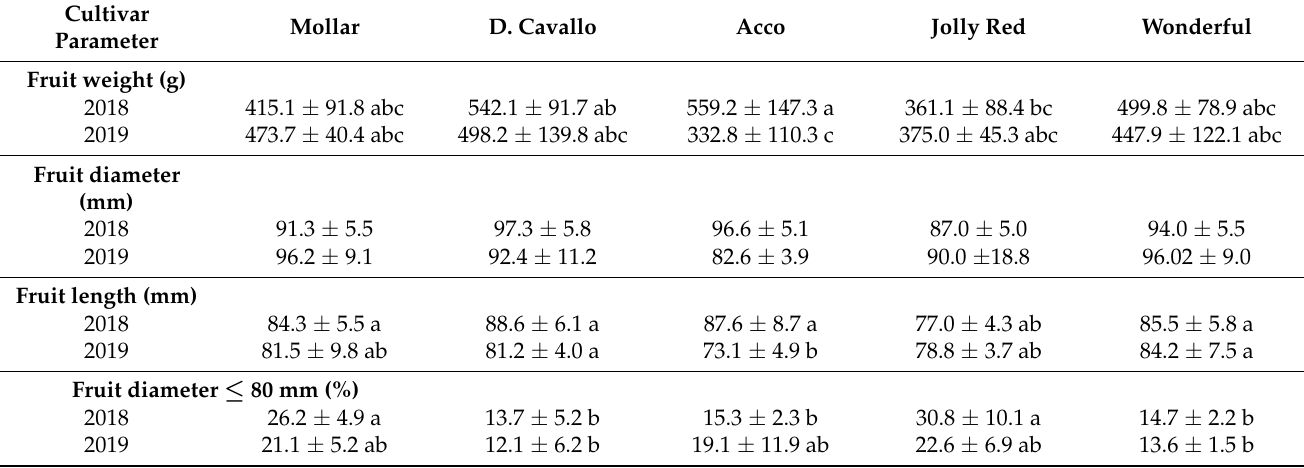
Table 2. Fruit characteristics of different pomegranate cultivars in 2018 and 2019